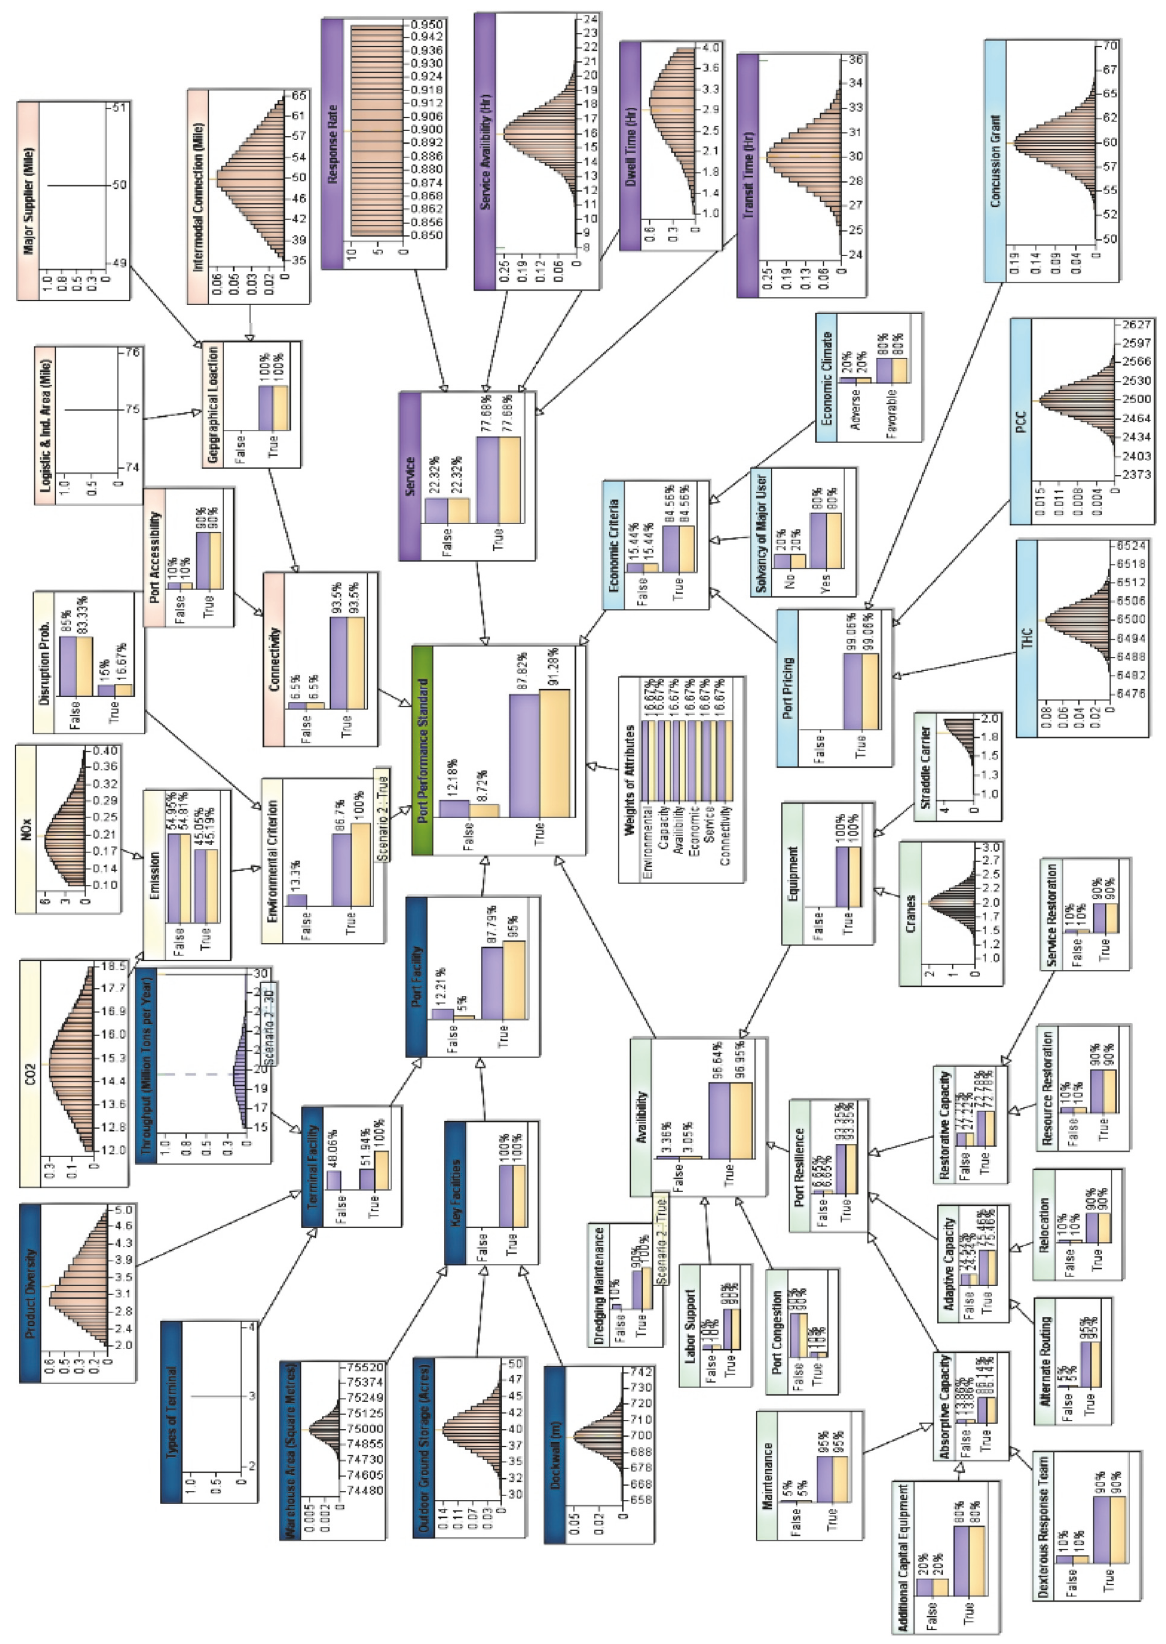
Figure 6: The developed BN model for scenario